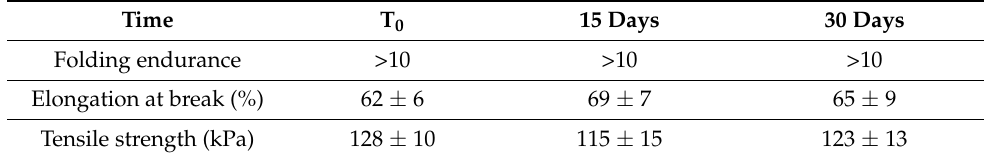
Table 2. Mechanical characterization of the mucoadhesive film: folding endurance, elongation and tensile strength of the 10 mg Montelukast (MTK) film exposed to normal (T 0 ) and freezing conditions (T 15 days and 30 days). Results are shown as the average of three to eighth films (mean with SD).